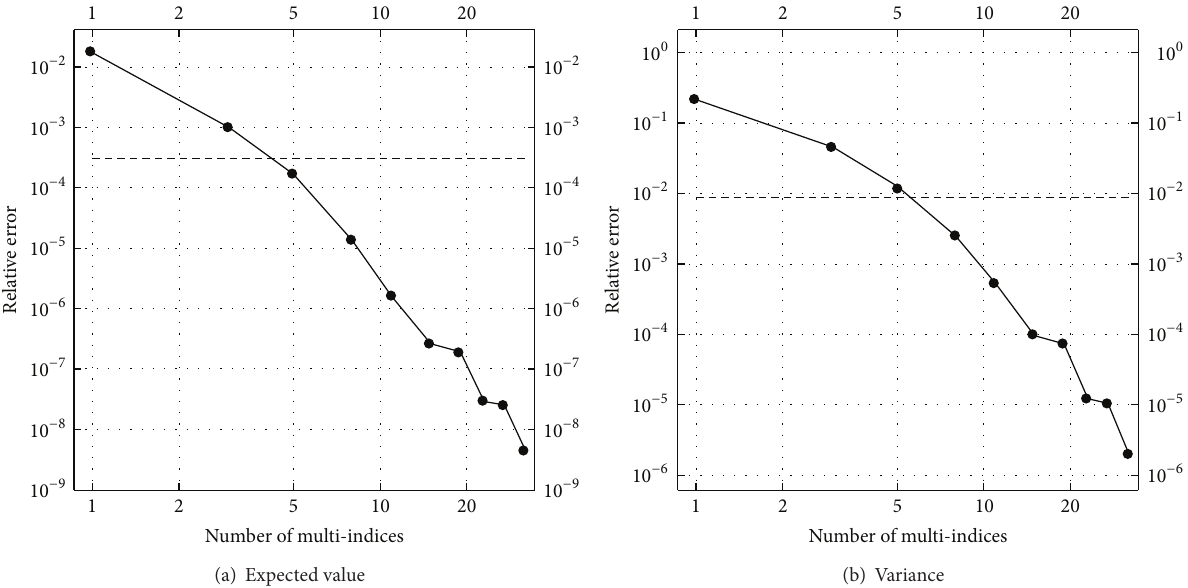
Figure 5: Case B: convergence in eigenvalue in the case of the 4 × 4 collocation grid: size of the multi-index sets versus relative error in the hybrid solution in loglog-scale. Plotmarkers: multi-index sets of different size. Dashed line: error between the overkill solution and the Monte Carlo